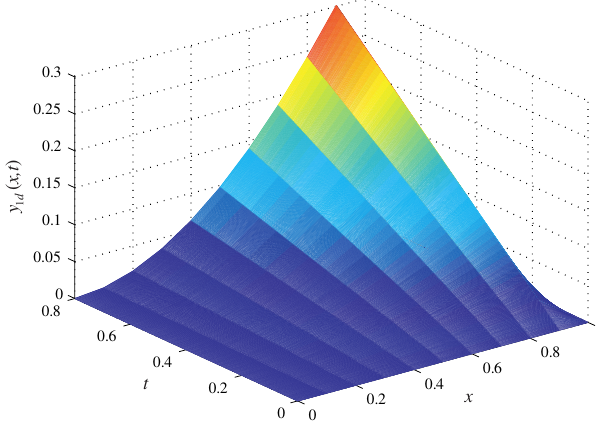
Figure 1. The desired output y 1 d